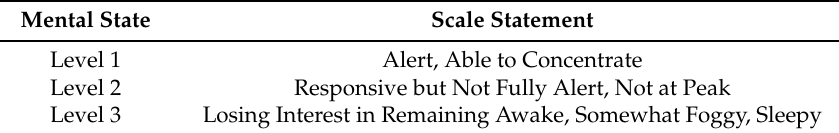
Table 1. Self-assessment